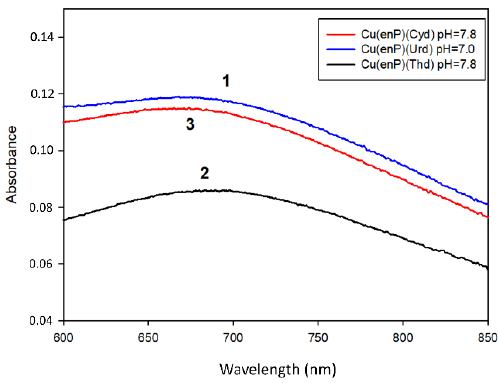
Figure 3. UV–Vis spectra of MLL` forms of complexes in ternary systems.